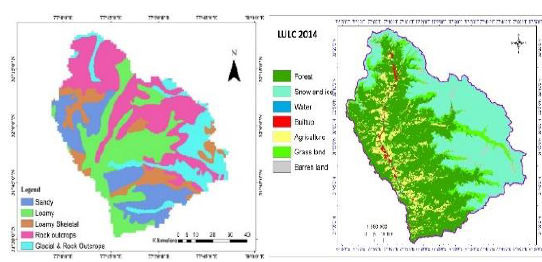
Figure 2.1. Soil Map (NBSS&LUP), LULC map (2014)